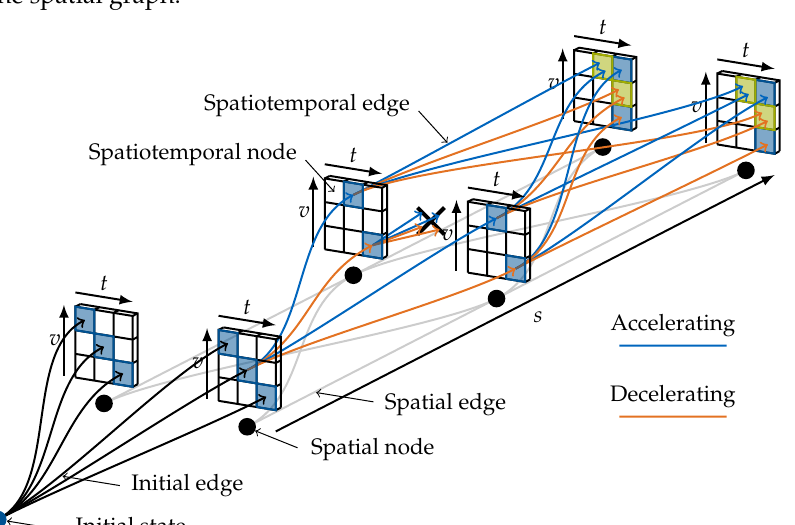
Figure 3. Spatiotemporal graph. The sampling procedure connects the initial state with the spa- tiotemporal state lattice. A graph search follows, starting at the connected nodes (here, only shown for one